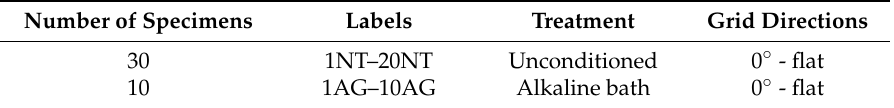
Table 1. Monotonic tensile tests matrix. NT for unconditioned and AG for aged specimens.